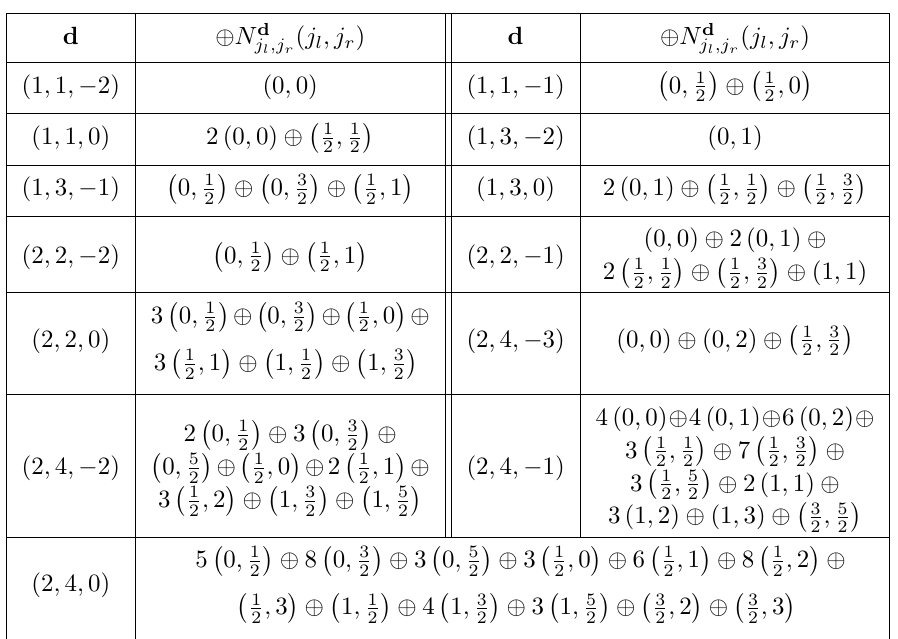
Table 12. BPS spectrum of SU(2) π + 1 Adj theory for d 1 ≤ 2 and d 2 ≤ 4 . Here, d = ( d 1 , d 2 , d 3 ) labels BPS states with charge d 1 m 0 + d 2 φ + d 3 m 1 . The states related by the symmetry d 3 ↔ − d 3 are omitted in the